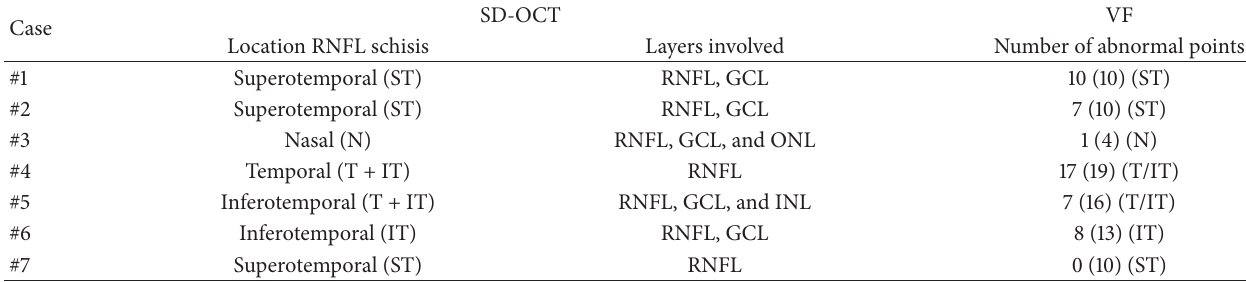
Table 2: Characteristics of SD-OCT and visual field of each